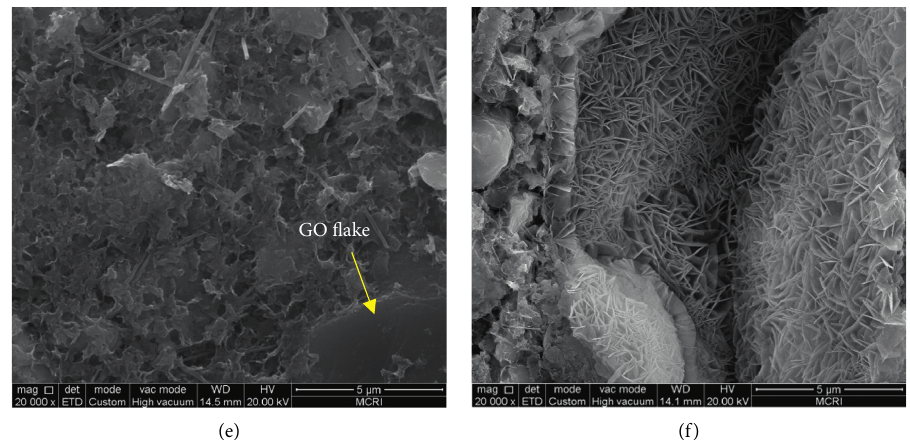
Figure 11: SEM images of structures of cement/loess and GO/cement/loess samples at 28d: (a) cement/loess without GO; (b) 0.03% GO/ cement/loess; (c) 0.06% GO/cement/loess; (d) 0.09% GO/cement/loess; (e) 0.12% GO/cement/loess; (f) interwoven and flower-like structure.